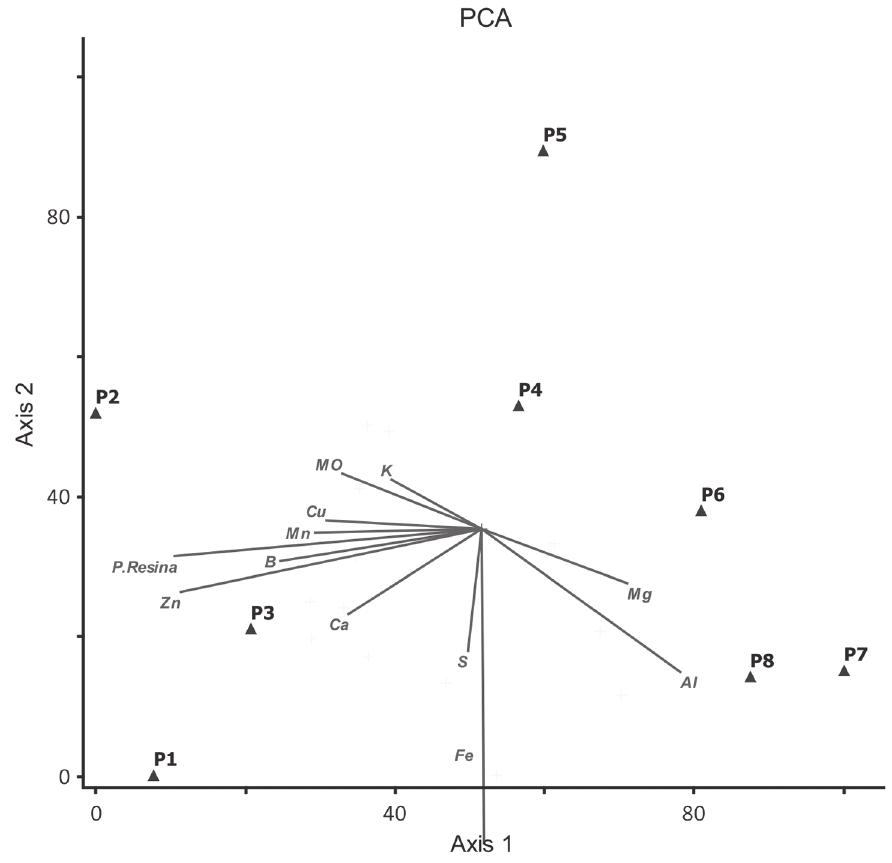
Figure 3 - Dendrogram produced through group mean (UPGMA) for the plots analyzed through the Sørensen similarity index in the floristic study on an escarpment slope in the Serra de Maracaju, Mato Grosso do Sul, Brazil (cophenetic correlation = 0.71).